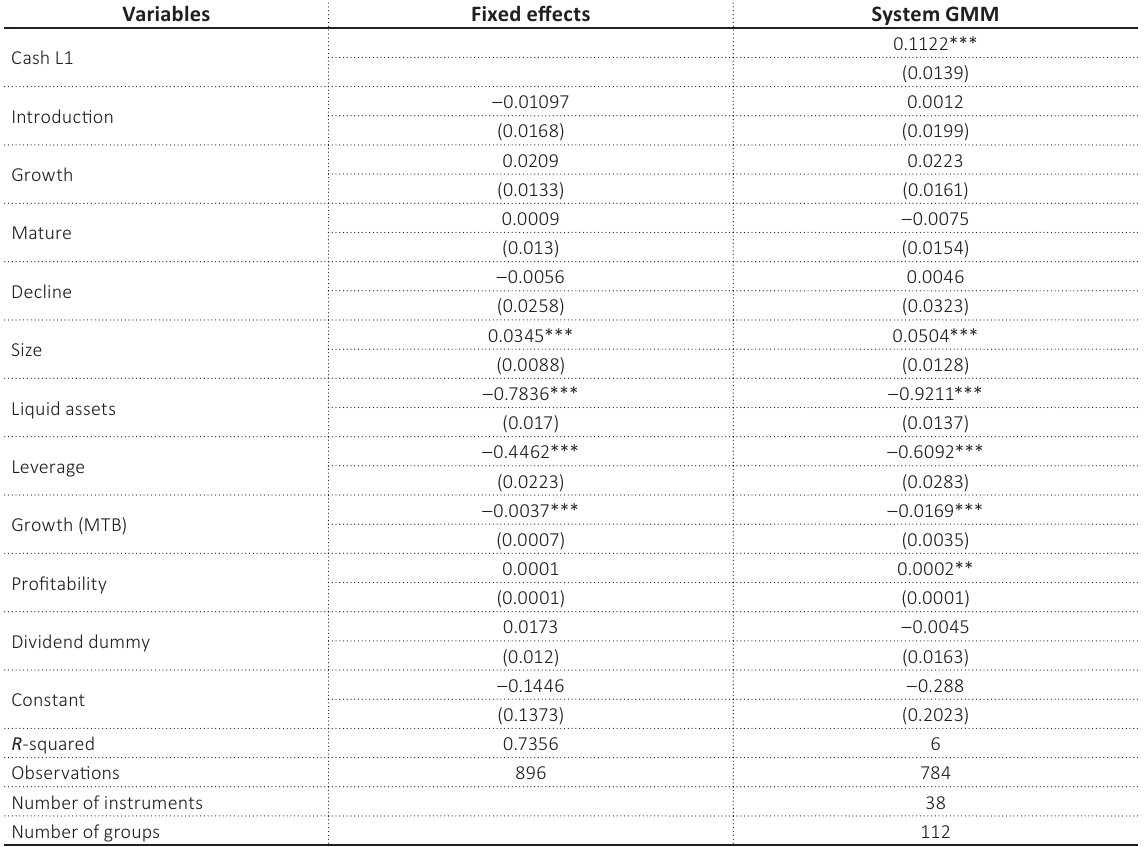
Table 5. Panel data regression